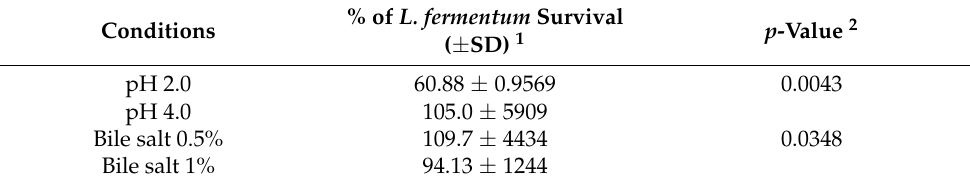
Table 7. L. fermentum ATCC 23271 survival rate in the presence of acidic pH and bile salts. Conditions